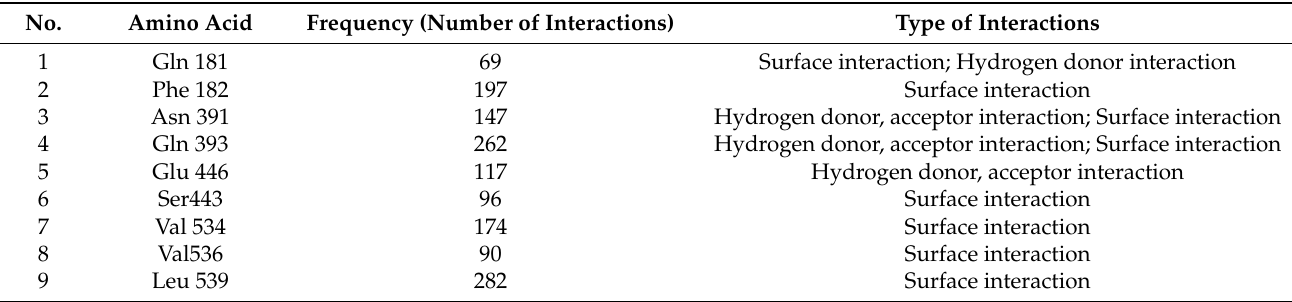
Table 6 . Frequency of amino acids interacting with amino acids in the binding site .